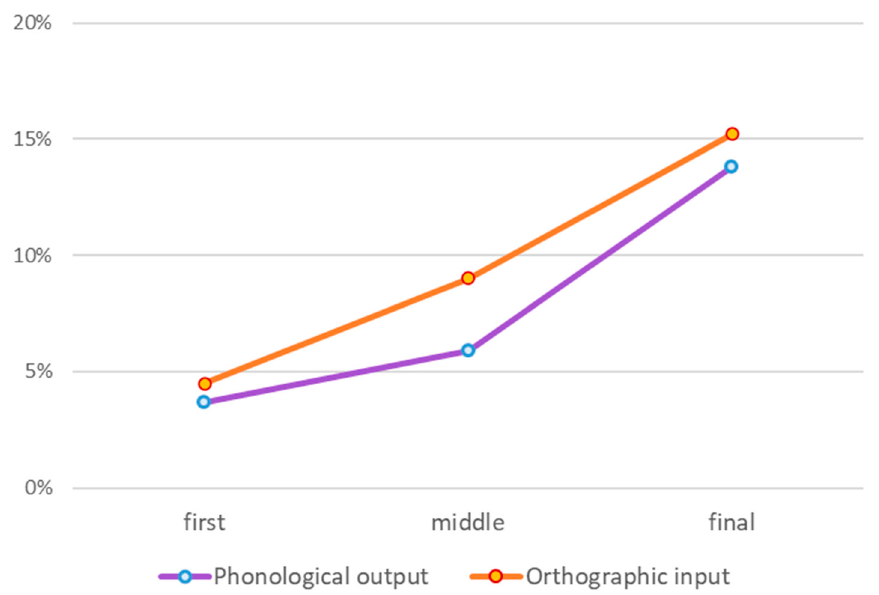
Figure 8. Percentage of consonantal migrations between words in first, middle and final positions. The same pattern is revealed when we analyze only the morphological affixes or only the root letters (again, out of the potential for lexical migrations): for morphological af- fixes, both the phonological output group and the orthographic input group made far more errors in the final morphological letter than in the first morphological letter. In the phonological output group, there were 6% morphological migrations in the first letter, and 38% in the final letter; in the orthographic input group, there were 7% morphological migrations in the first letter and 45% in the final letter (all analyses were made out of the number of pairs that included morphological affixes in the relevant position). As for root letter migrations, the first, middle and final letters migrated in 3%, 4%, and 8%, respec- tively in the phonological output group, and in 0%, 7%, and 10% in the orthographic input group. This indicates that for the root letters too, the final position is the most susceptible to migrations. It also suggests that in orthographic input impairments, the first letter of the root does not migrate. Because the word pairs we used were not constructed to